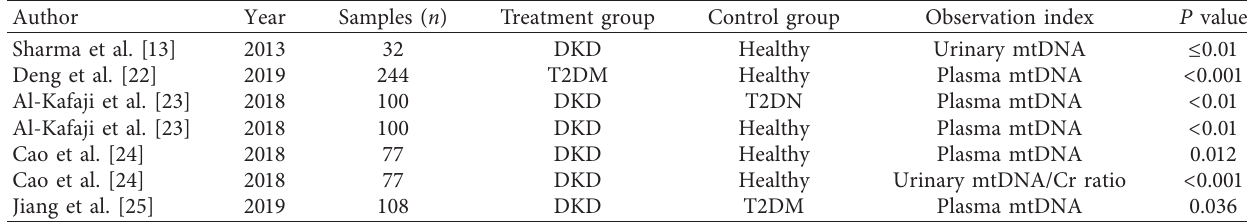
Table 1: Clinical trial about mtDNA changes in DKD or